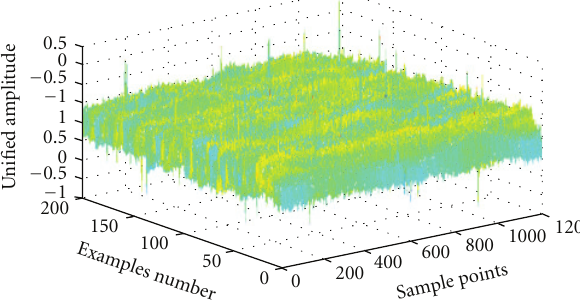
Figure 8: Mesh patterns of 200 examples for line trip.